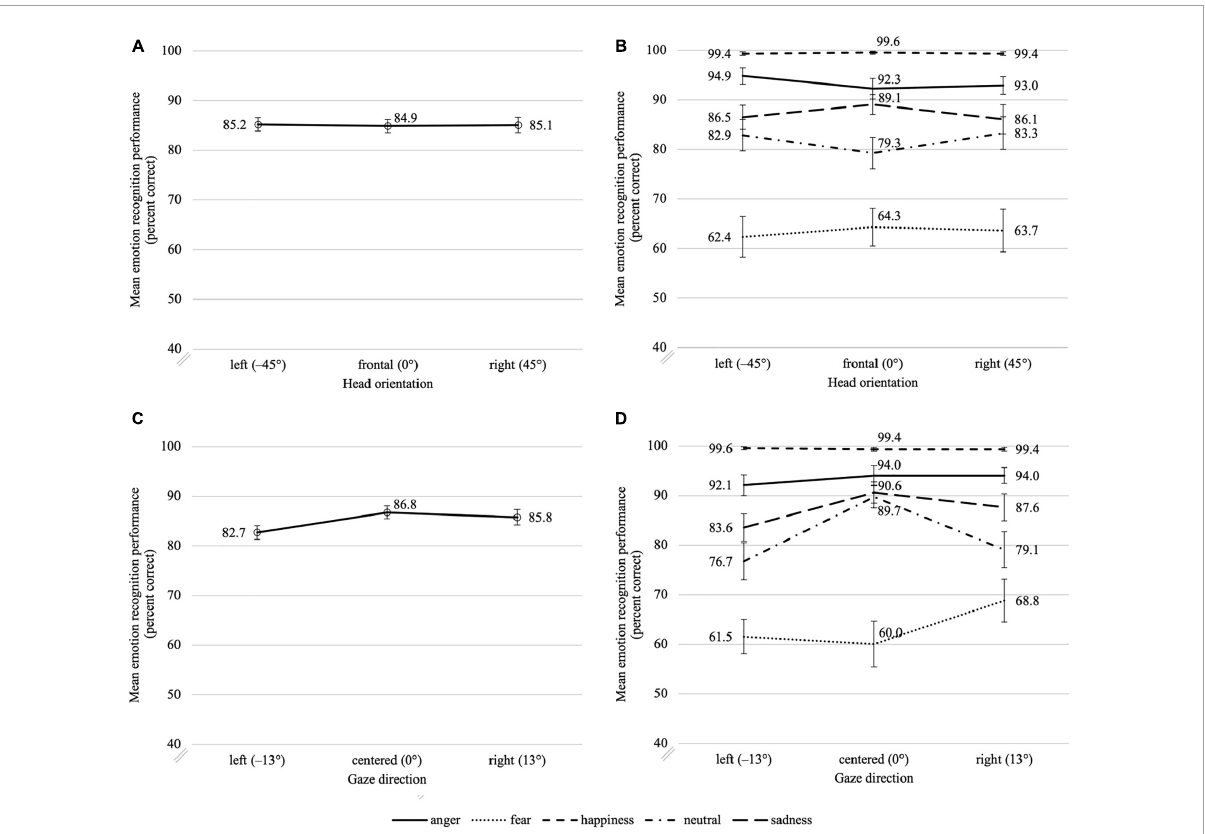
FIGURE5 Mean emotion recognition performance in percent correct for uncovered faces as a function of head orientation (top row, A,B ) and gaze direction (bottom row, C,D ), aggregated across all facial expressions (left column, A,C ) and additionally as a function of the five different facial expressions (right column, B,D ). Error bars indicate the standard error of the mean (SEM) of the 39 individual data points in each